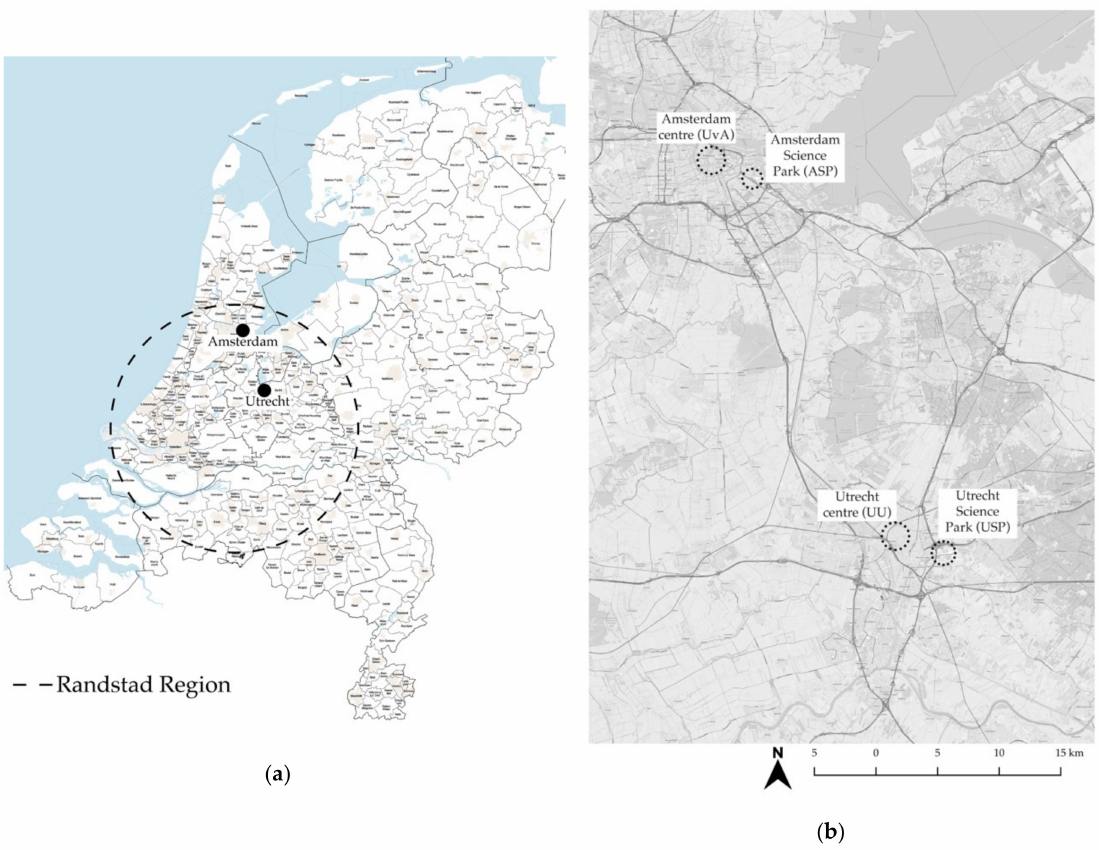
Figure 1. Amsterdam and Utrecht: ( a ) Location in the Netherlands [77]; ( b ) Amsterdam and Utrecht inner-city campuses and SPs in the context of the